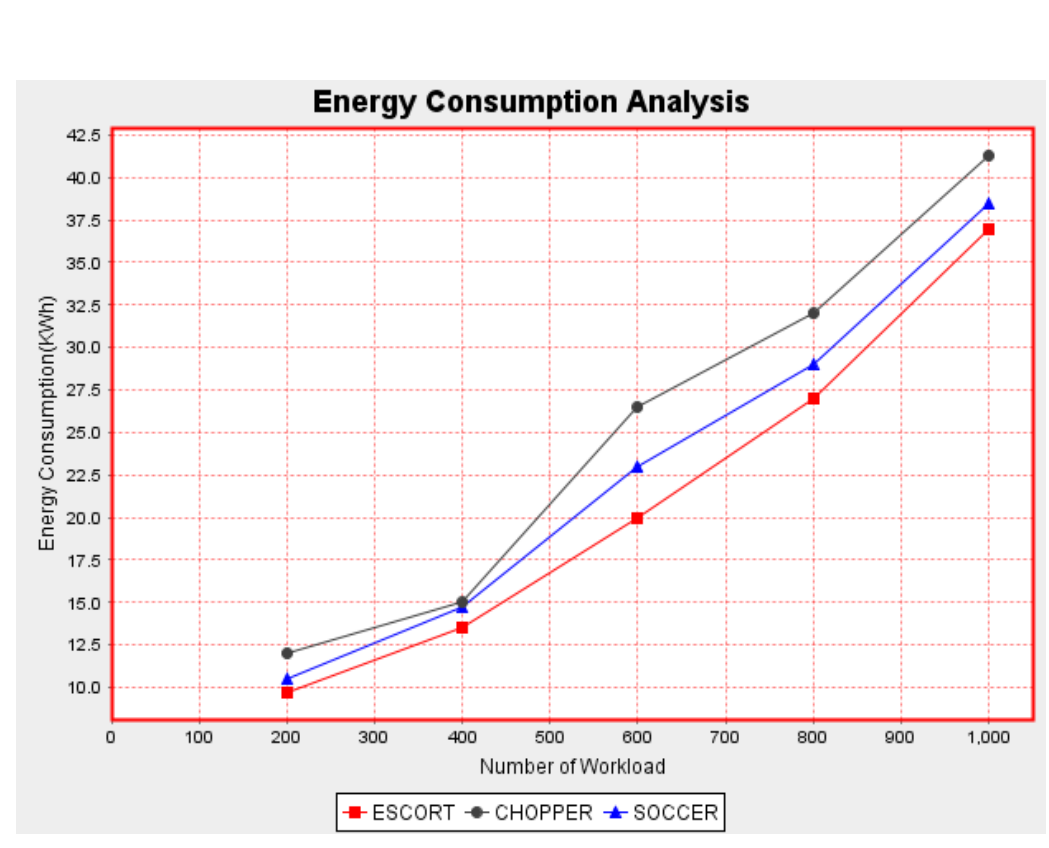
Figure 4. Energy consumption